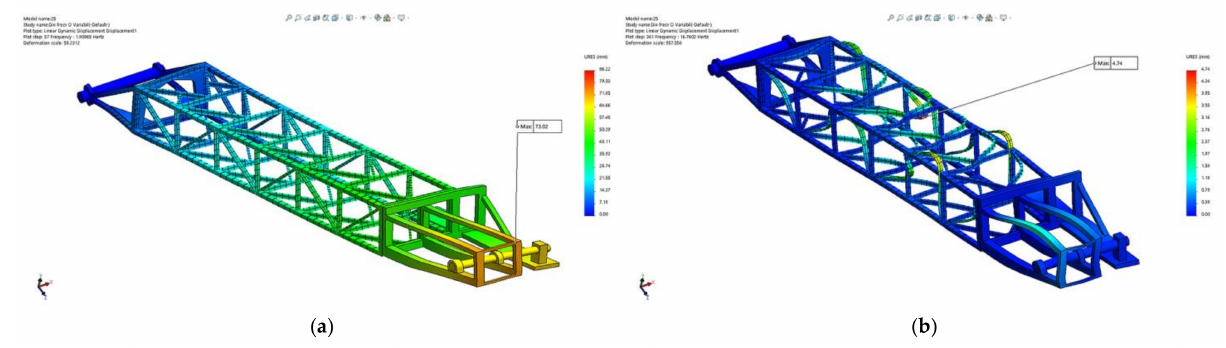
Figure 17. Location and shape of displacement of the boom for the maximum height excavation position (1). ( a ) Mode 2, frequency of 1.91 Hz; ( b ) Mode 12, frequency of 16.76 Hz.